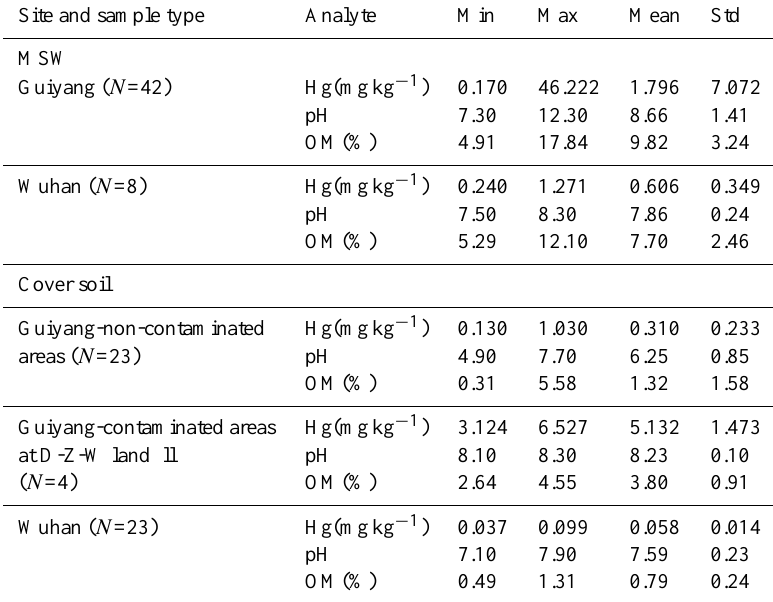
Table 2. Statistical summaries of Hg, pH and organic matter in the MSW and cover soil at 5 studied landfills. Site and sample type